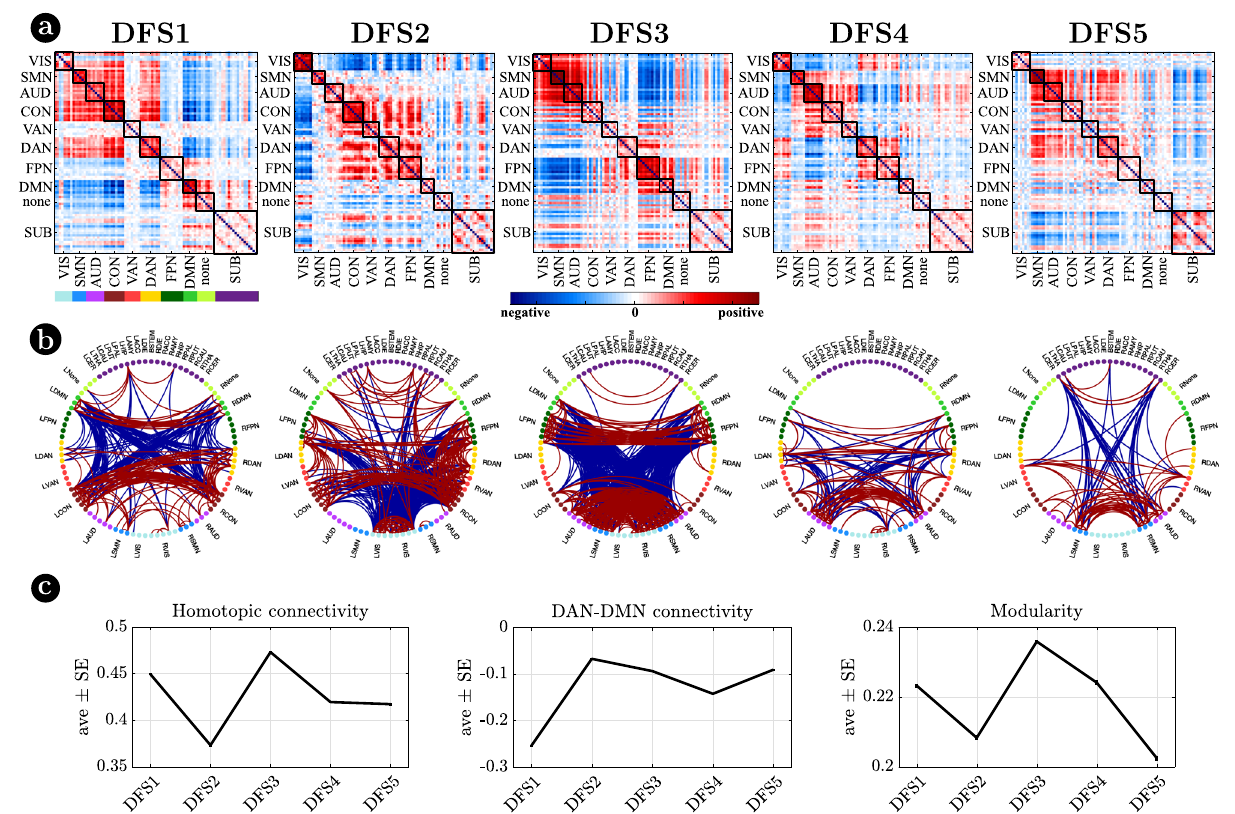
Fig.2|Dynamicfunctionalstates(DFSs).a Representationofthe5DFSsinmatrix form (positive and negative weights are red and blue, respectively). b The same DFSs are described through a circular graph representation. In each column, the positive (red) and negative (blue) strongest links for each state are represented. Network belonging is color-coded. c Average and standard error of (left) the average homotopic inter-hemispheric connectivity within each network; (center)